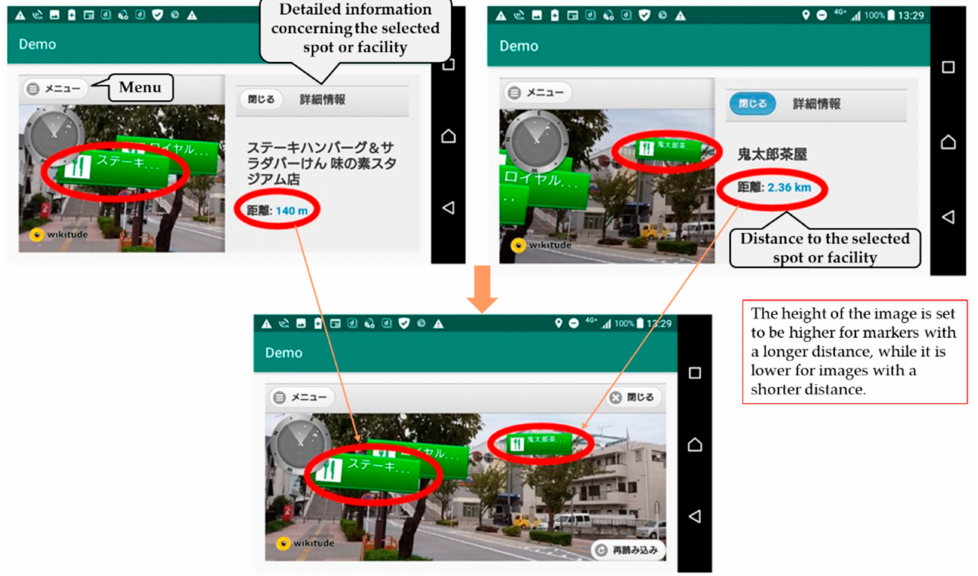
Figure 10. Height modification of images displayed based on the updated distance